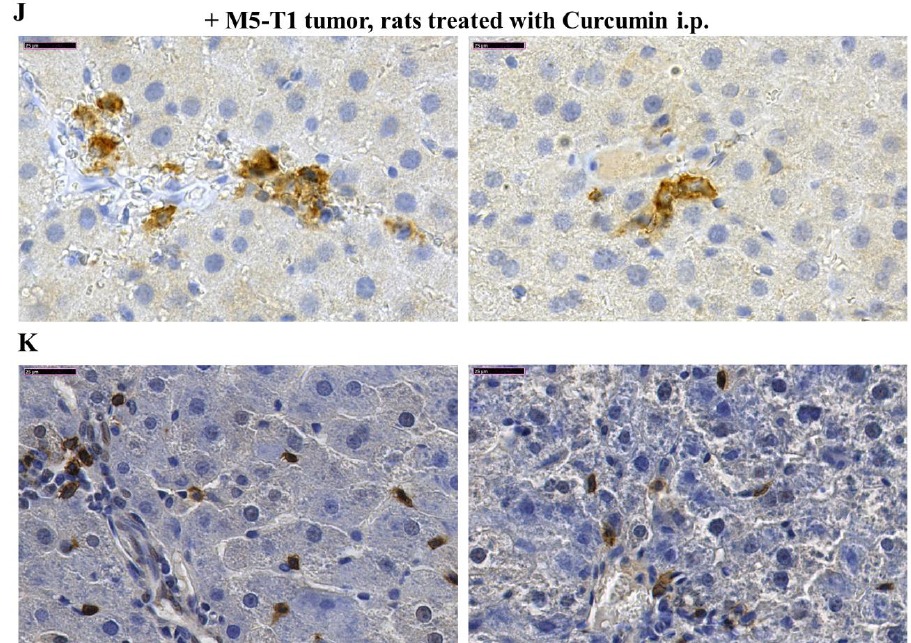
Figure 1. Experimental design and characteristics of the activated lymphocytes infiltrating the liver parenchyma of curcumin-treated rats. ( A ) Scheme of experimental design representing how liver samples from the “Tumor” and “Tumor + Curcumin” groups were selected for proteomic and histological analysis. ( B , C ) Histological features of two selected rats belonging to the “Tumor” group showing di ff erent stages of M5-T1 tumor development, initial stage ( B ), and advanced stage ( C ). Left, general views ( × 25, the scale bar represents 1 mm). Middle, magnification ( × 100, the scale bar represents 250 µ m) of the yellow rectangles showing the histological features of the liver parenchyma used for proteomic analysis (at distance from the tumor front). Right, beginning of muscle invasion at initial stage ( B ) and invasion of the pancreas at advanced stage ( C ). ( D ) Example of rat at final stage from the tumor bank and excluded from sample selection. Left, general view ( × 6.5, the scale bar represents 5 mm), showing dramatic invasion of the liver and gut. Middle, magnification ( × 100, the scale bar represents 250 µ m) of the yellow rectangle showing extended invasion of the liver parenchyma by tumor cells. Right, magnification ( × 100, the scale bar represents 250 µ m) showing tumor cells invading the muscularis externa of the gut. ( E ) Quantification of lymphocytes in high-magnification fields. ( F ) Comparison of lymphocyte sizes. High-magnification views ( × 800, the scale bars represent 25 µ m) of liver parenchyma from normal rats ( G ), rats with M5-T1 tumor (( H ), tumor cells are indicated by yellow arrows), and rats with M5-T1 tumor treated with curcumin i.p. ( I ). Isolated tumor cells (green arrows, left and middle photographs in ( I )) exhibiting morphological changes in comparison with ( H ), with numerous activated lymphocytes present in the sinusoids and converging toward the residual tumor cells. Two representative examples of immunohistochemical staining of CD3 + lymphocytes ( J ) and CD8 + lymphocytes ( K ) infiltrating the liver parenchyma of rats with M5-T1 tumor treated with curcumin i.p. (two di ff erent